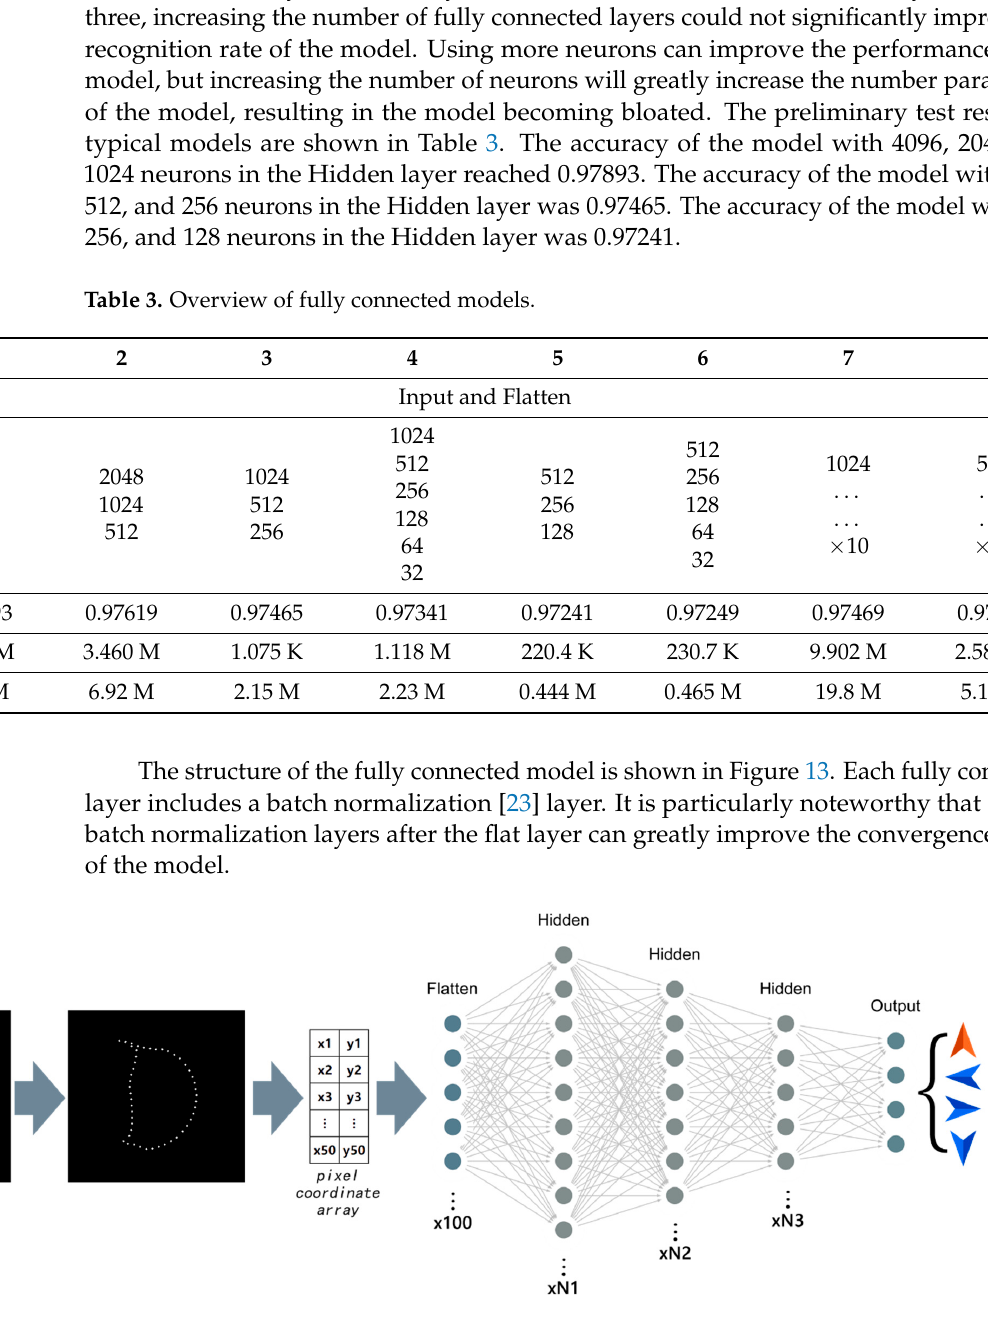
Table 3. Overview of fully connected models.